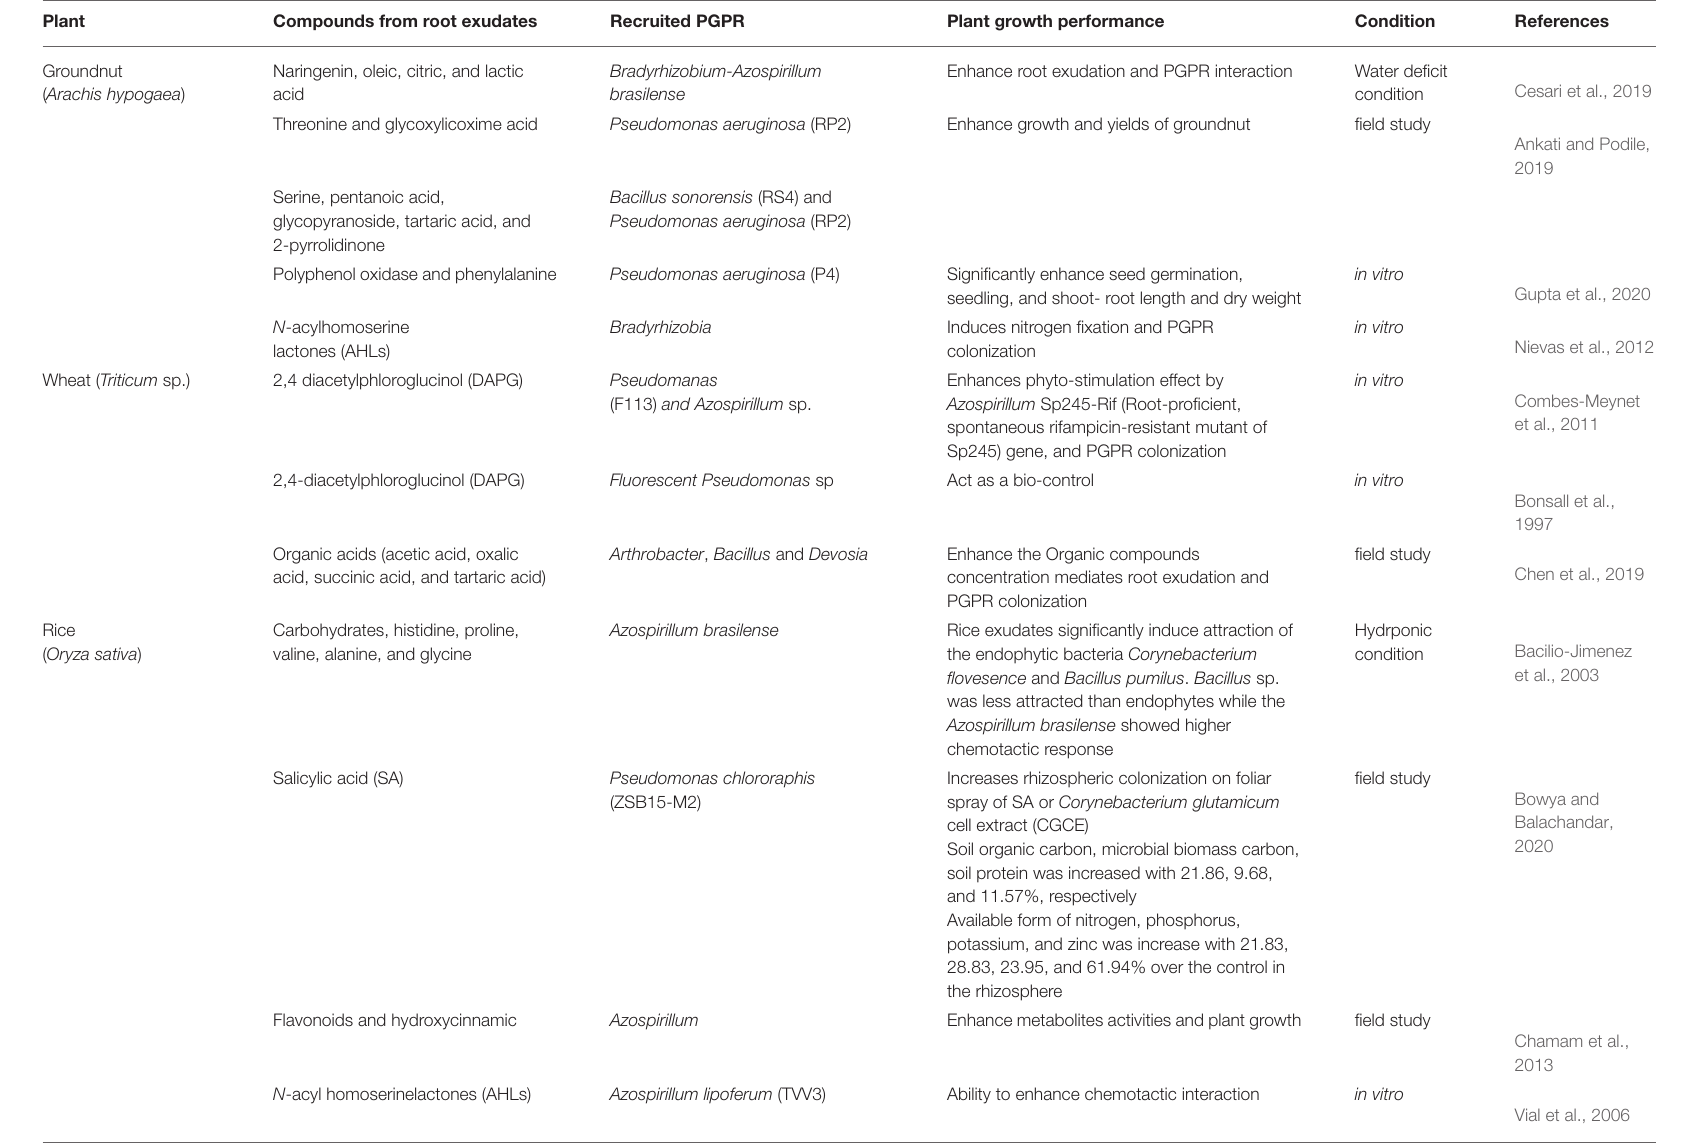
TABLE 1 | Compounds from plant root exudates recruit perfect plant growth-promoting rhizobacteria (PGPR) improving plant growth performance.